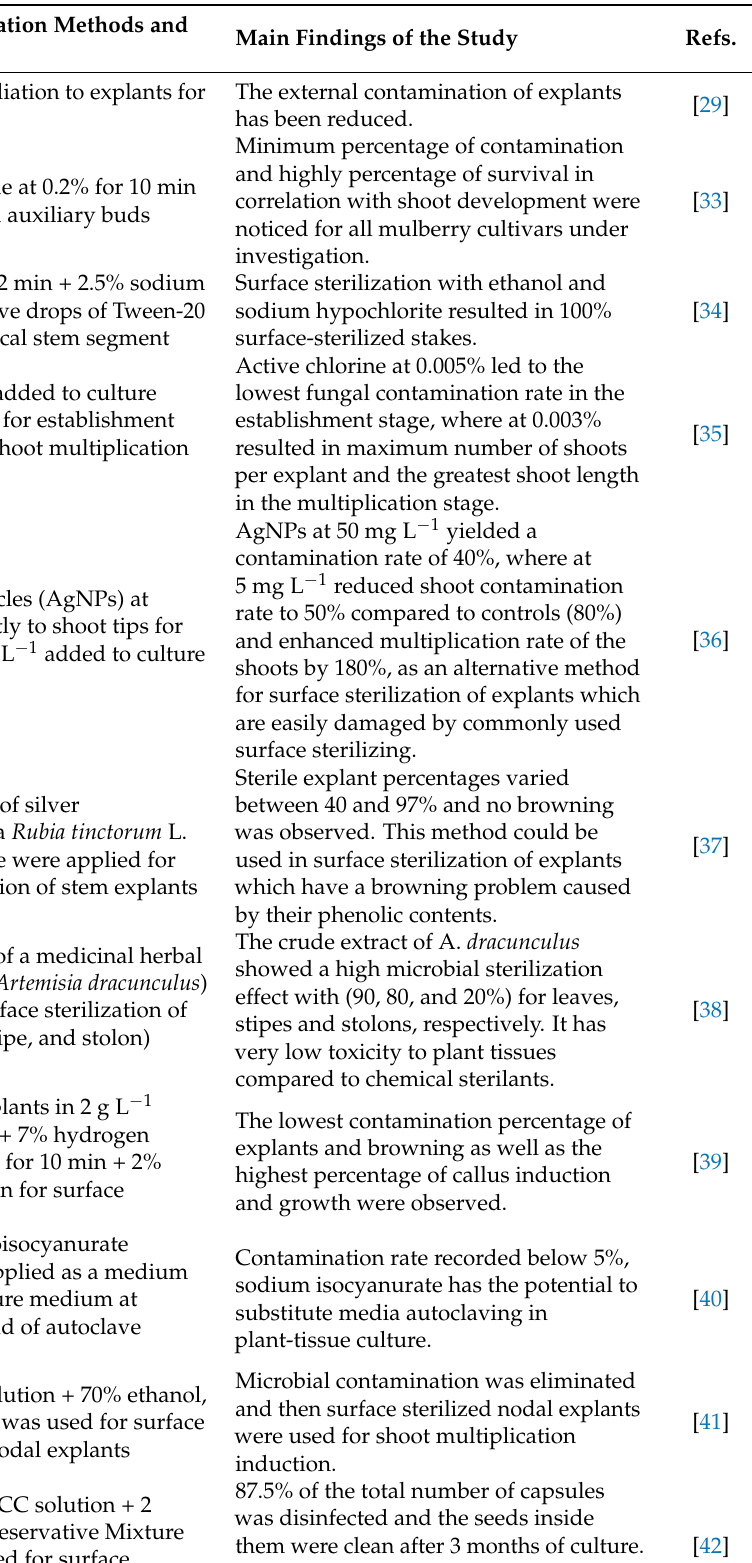
Table 1. Some surface-sterilization methods for external contamination used in tissue-culture